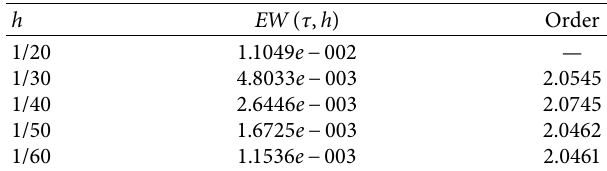
Figure 1: The evolution mesh (a) and contour map (b) of numerical solution. Table 1: Numerical convergence of scheme (50)–(59) in time Table 3: Numerical convergence of scheme (50)–(59) with λ � 1 ( h � 1/100, T � 1).